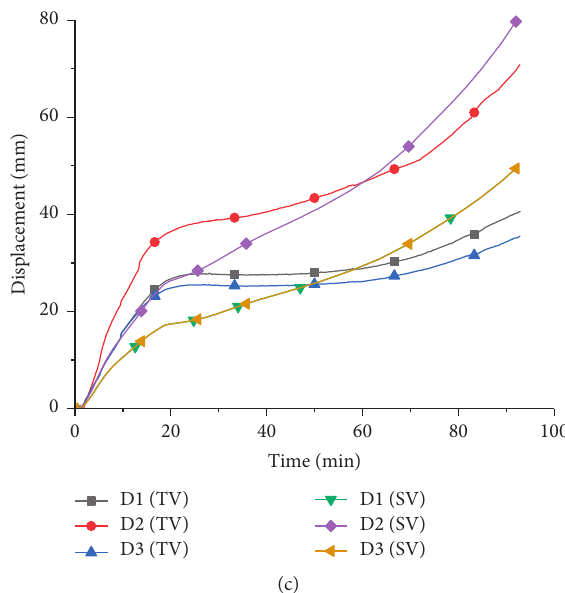
Figure 16: Comparison of displacement developments of three tested specimens: (a) SCB-1, (b) SCB-2, and (c)